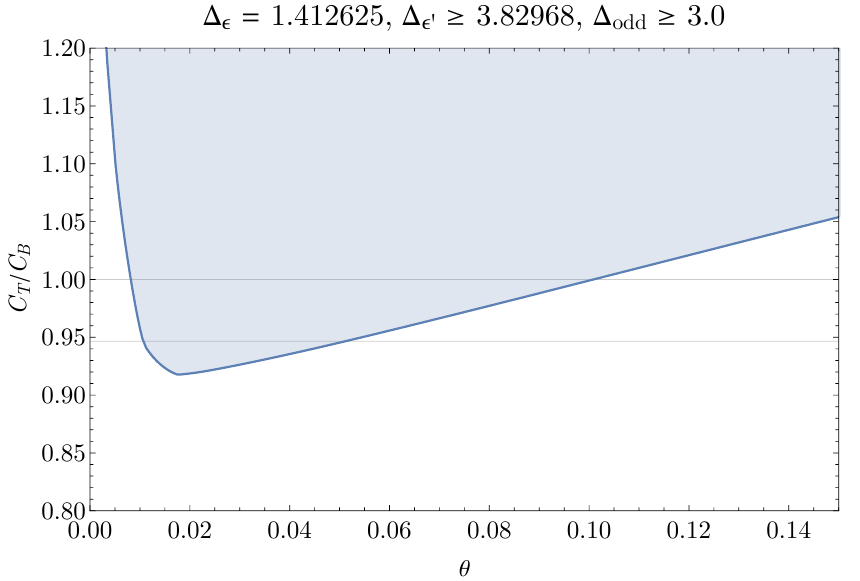
Figure 16 . Lower bound on C T as a function of (cid:18) assuming known low-lying gaps in the parity-even scalar spectrum in the 3d Ising CFT, combined with the assumption that the leading parity-odd scalar is irrelevant.